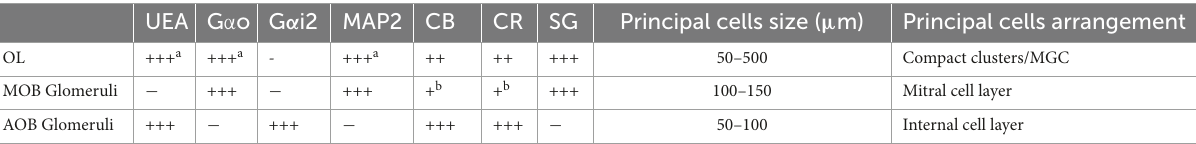
TABLE 2 Comparison of immunohistochemical and structural features of the olfactory limb, and the glomeruli of the main and accessory olfactory